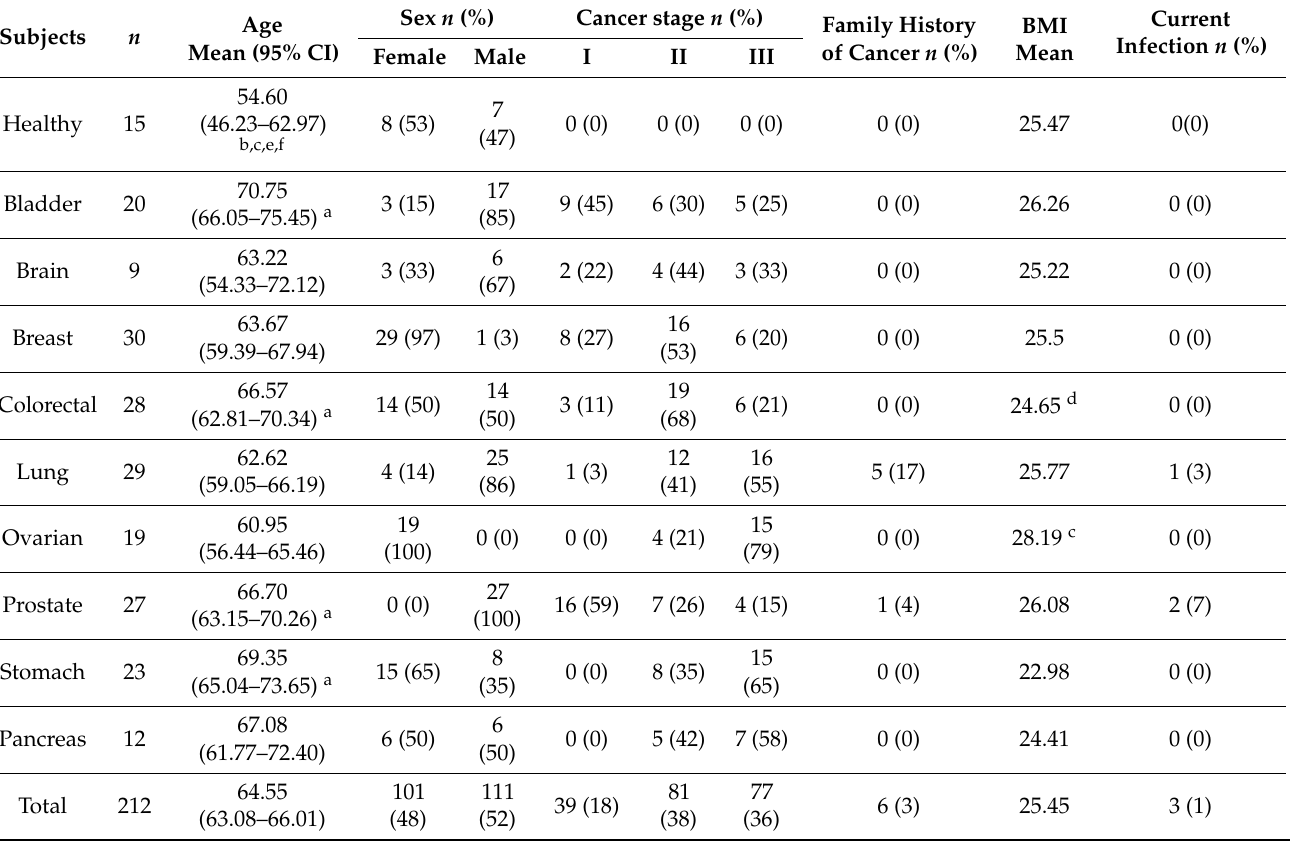
Table 1. Patients